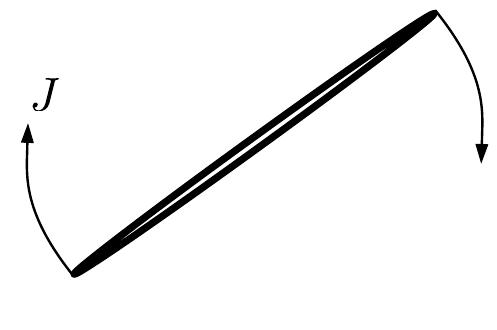
Figure 2 . Folded string rotating with angular momentum J